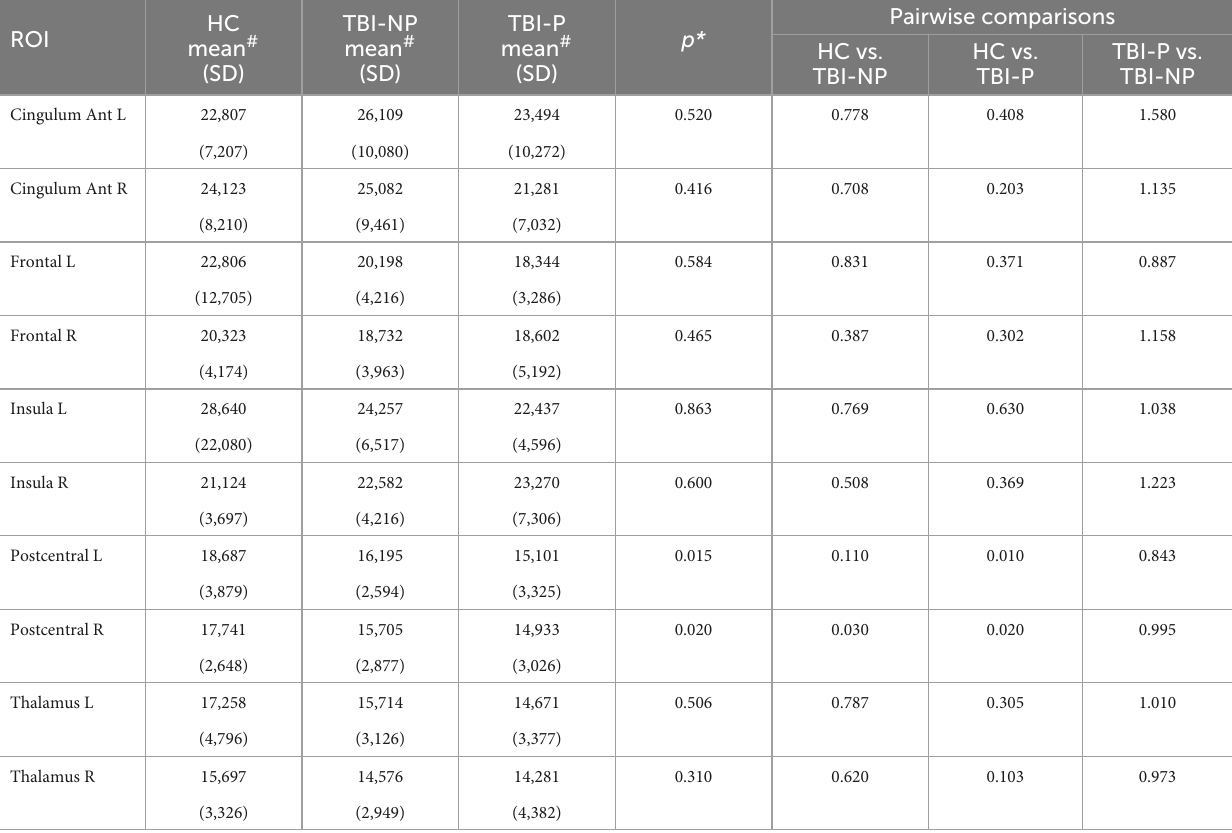
TABLE 4 Results from analysis of covariance (ANCOVA) controlling for age between HC ( N = 31), TBI-NP ( N = 17) and TBI-P ( N = 16) groups for myo-i nositol ( m -Ins).